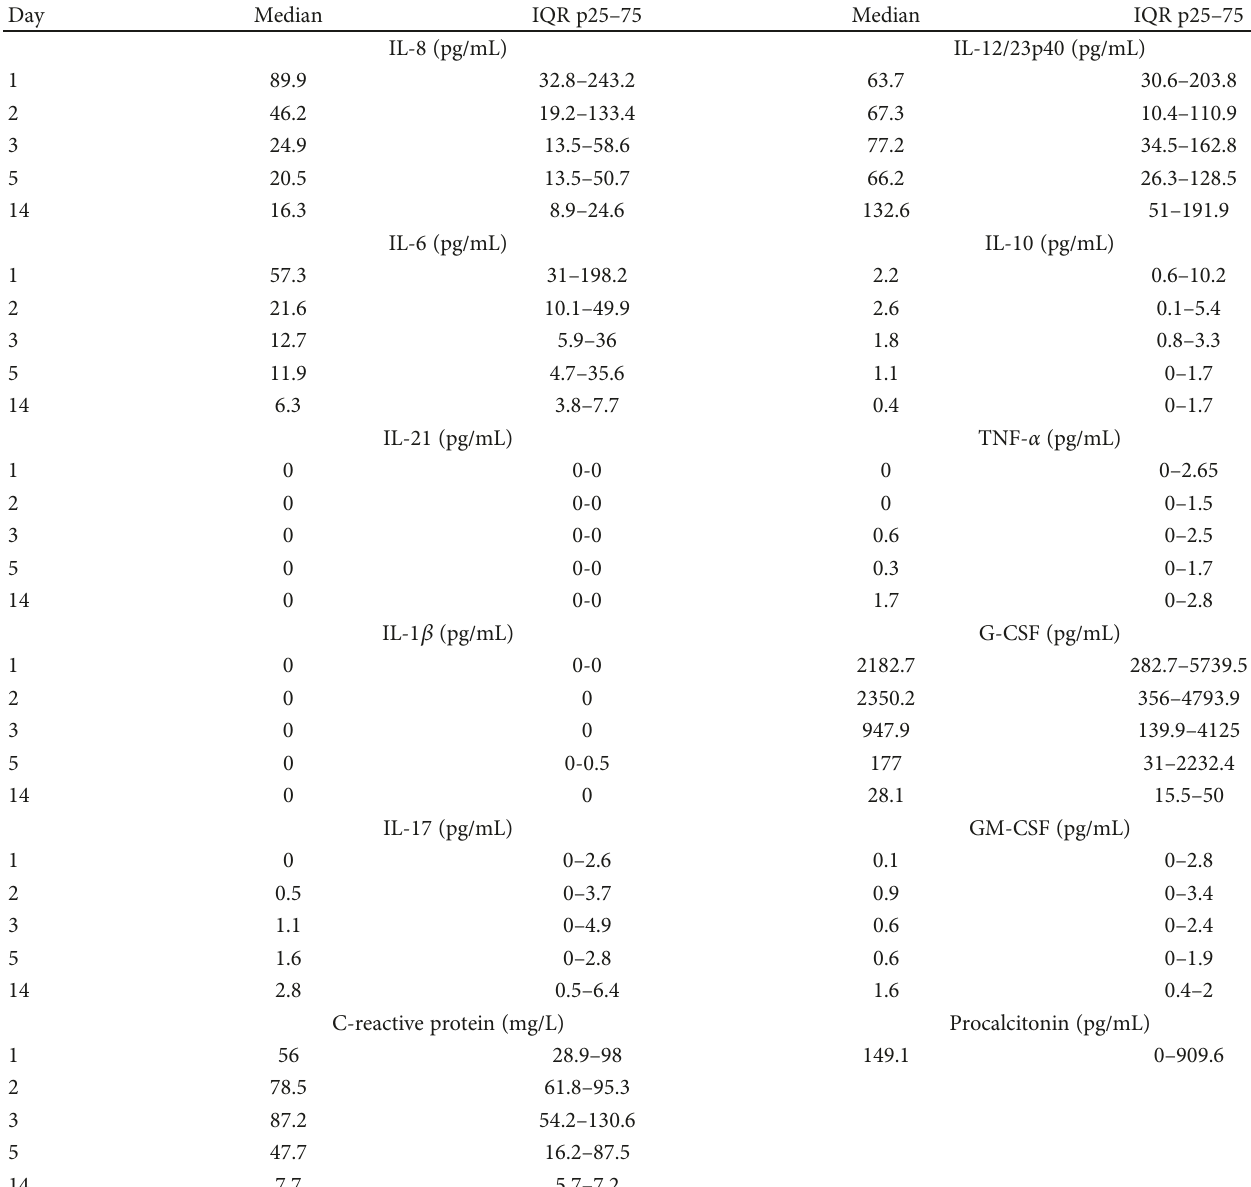
Table 3: Values of biomarkers in the 5 days of measurements in median and interquartile ranges (25 – 75 percentiles).